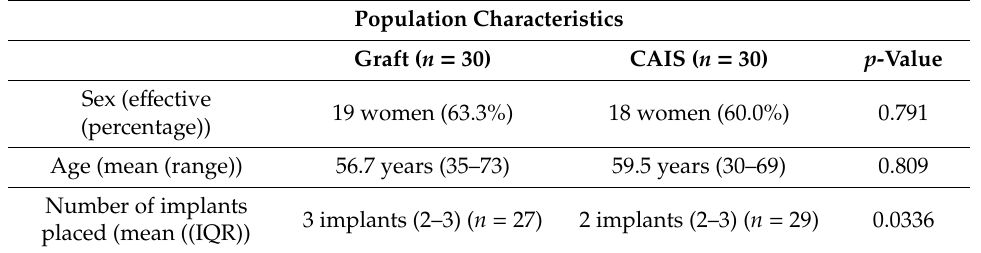
Table 1. Population characteristics. IQR, interquartile range. CAIS, computer-aided implant